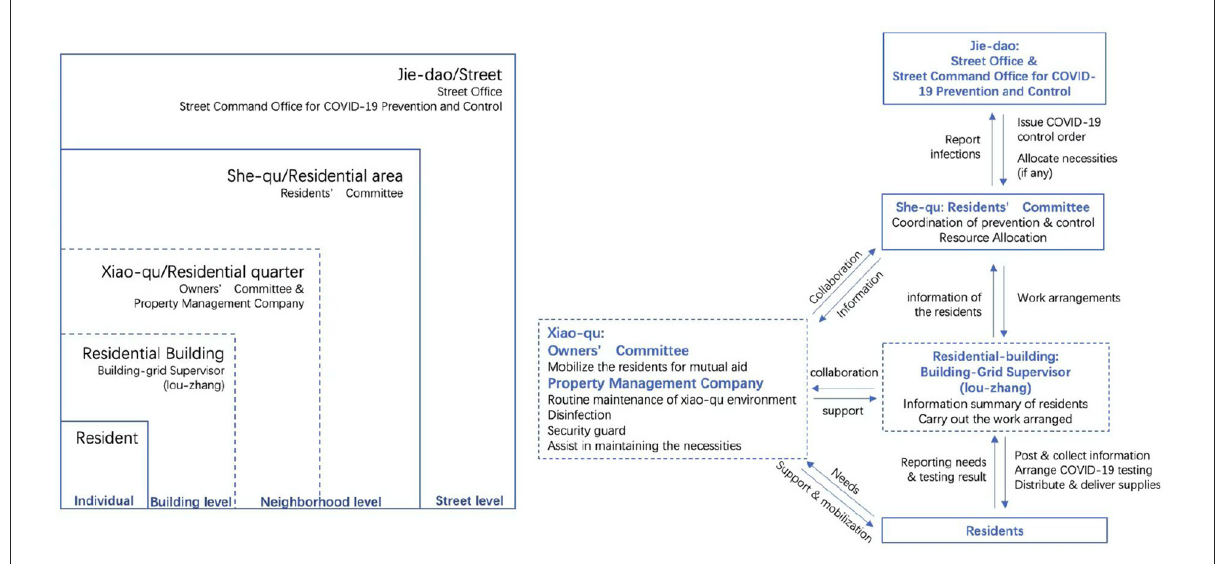
FIGURE1 The community governance structure in Shanghai during the outbreak of COVID-19 (1. The key personnel of the RC are often the grid head (she-qu level) and grid manager (xiao-qu level) of the grid management system. 2. Some commercial apartments that do not belong to any xiao-qu and some old xiao-qu that do not have OC or property management company are under direct management by the she-qu ; and in some residential buildings, there are no building-grid